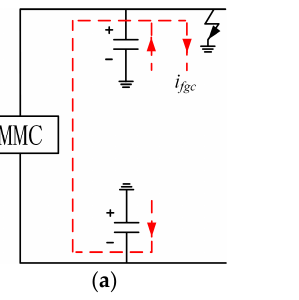
Figure 5. Theoretical value and simulation value of i fsm .